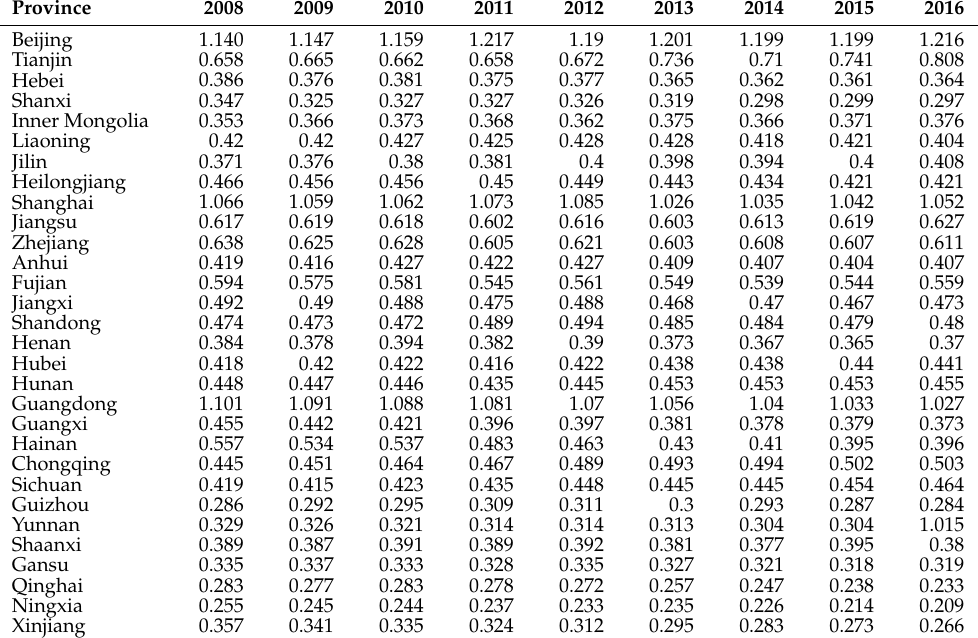
Table A1. The carbon emission efficiency data of 30 provincial-level administrative regions in China (excluding Taiwan, Hong Kong, Macao, and Tibet) from 2007 to 2016, which is given by Ning et al. (2021) [54].